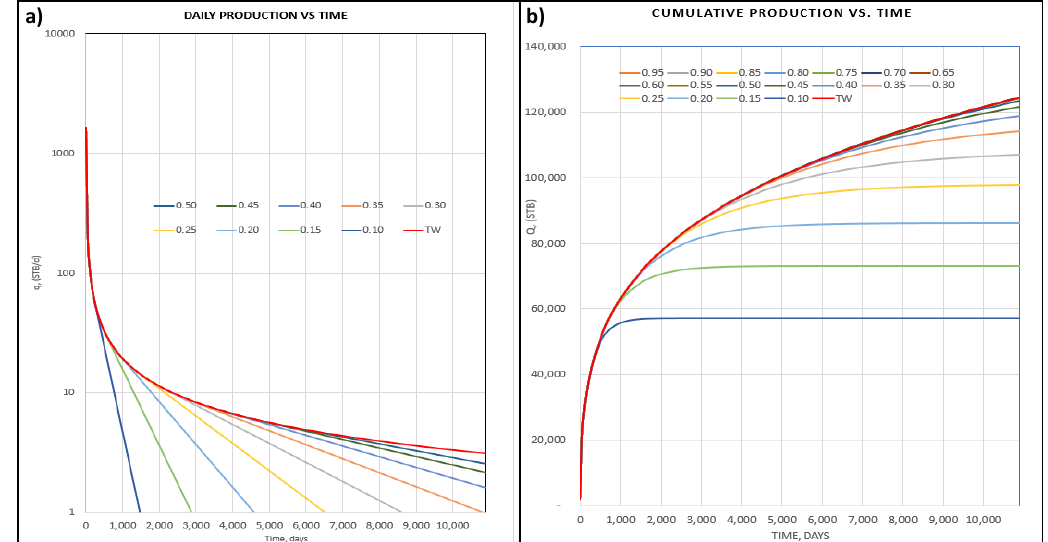
Figure A5. ( a ) Daily production rate from di ff erent well spacing, ( b ) cumulative production from Figure A5 . ( a ) Daily production rate from different well spacing, ( b ) cumulative production from different well di ff erent well spacing. ‘TW’ represents type well production with no impact from well spacing. ‘TW’ represents type well production with no impact from well interference.